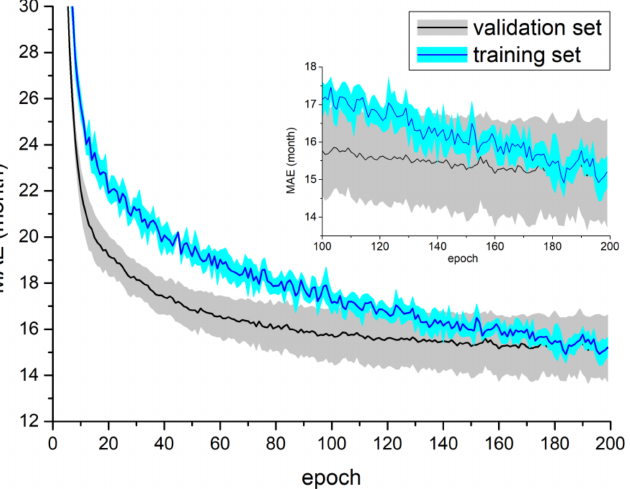
Figure 4. Training process for the MobileNetV2 DW model using the DXA dataset. Both figures present mean and standard deviation calculated from all folds in a single test. The top right part of the figure shows the scaled part of the plot for the last 100